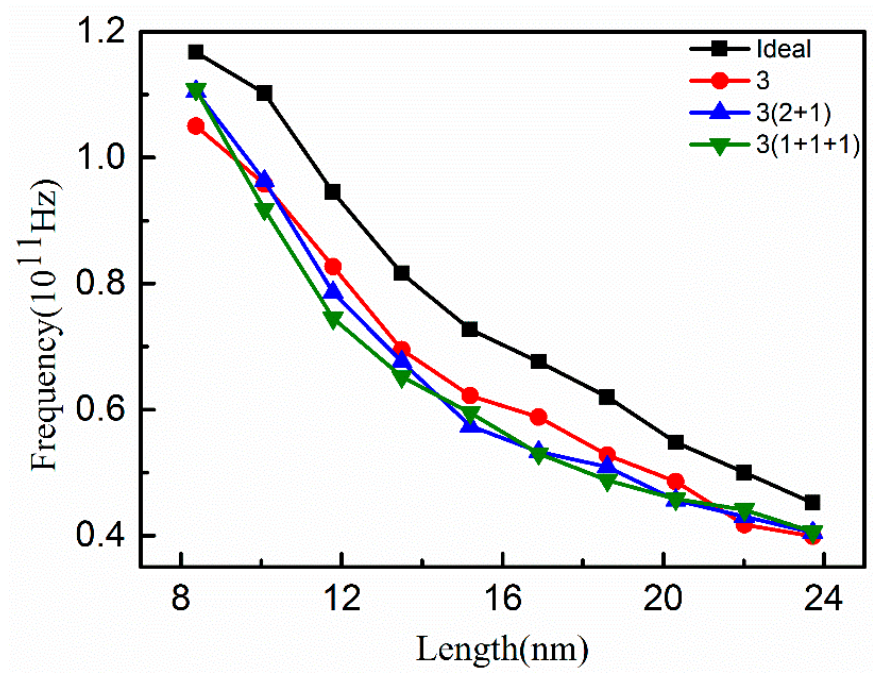
Figure 5. Variation of vibration frequency of graphene nanoribbons at different vacancy positions (V-3) with length.